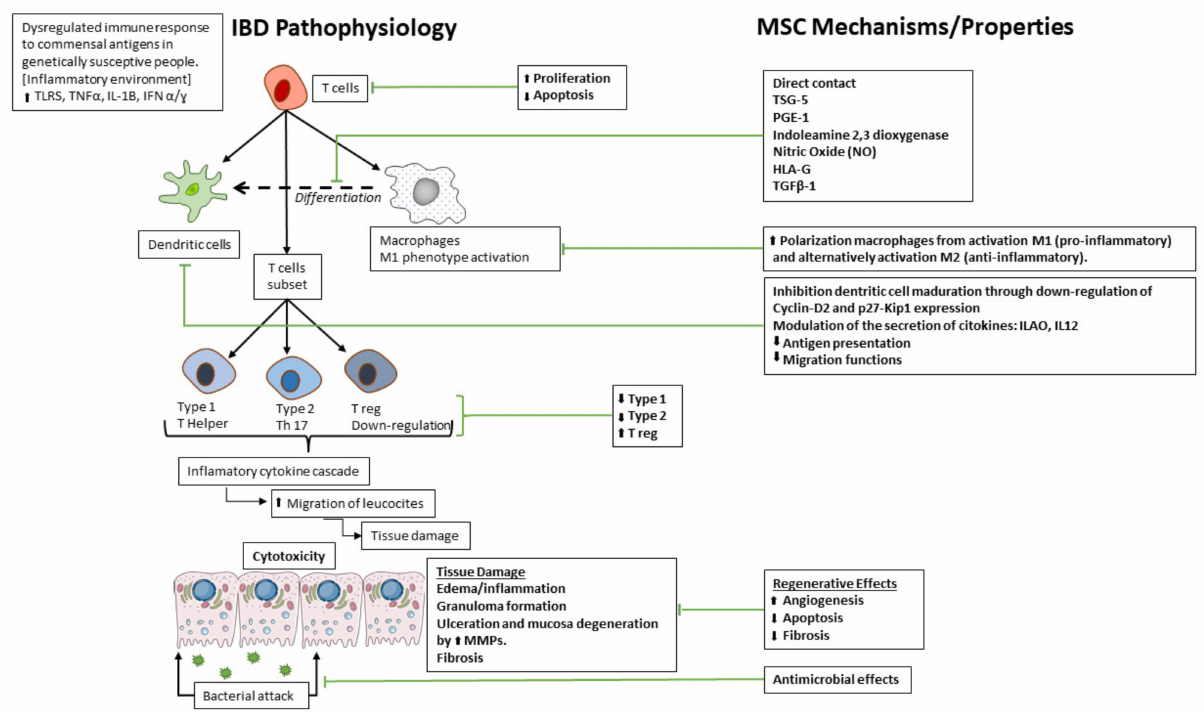
Figure 1. IBD pathophysiology and MSC